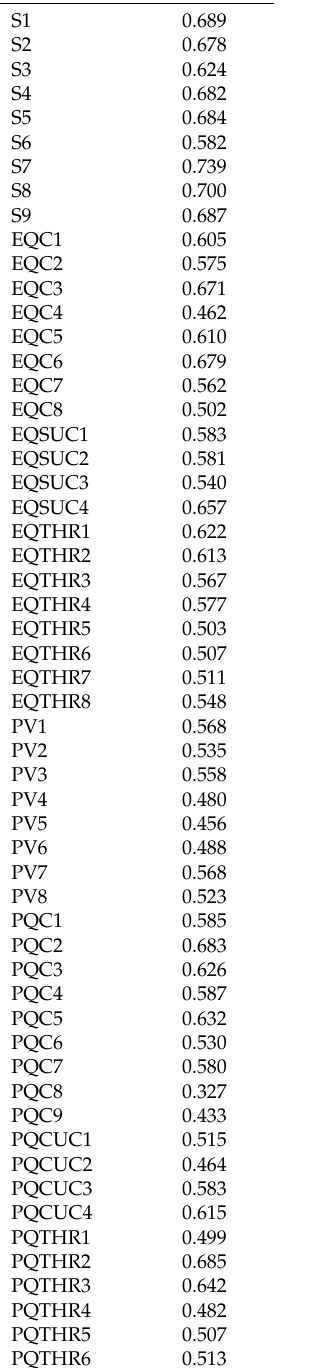
Table 5. Individual reliability of the indicators